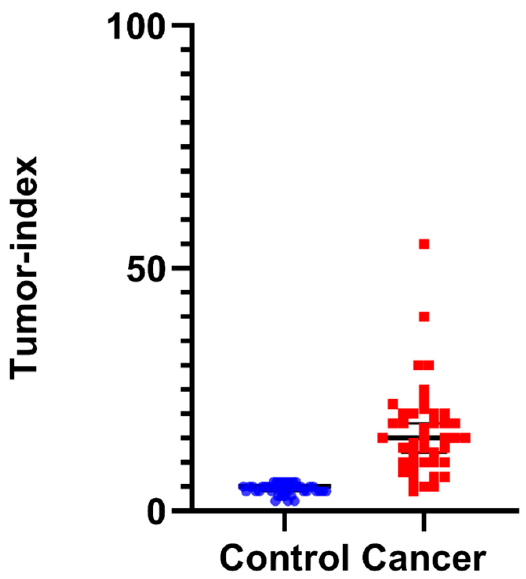
Figure 4. Quantification of tumor index in normal control samples versus tumor cells, as quantified by iFC: Tumor index scores (the sum of the % of cells in the S and G2/M cell-cycle phases) of individual patient samples are presented as blue or red dots, for normal and cancer tissue, respectively. Median percentages are shown as horizontal lines in each group. There is a significant difference between the two distributions, with cancer cells exhibiting a higher tumor index, indicative of malignancy.